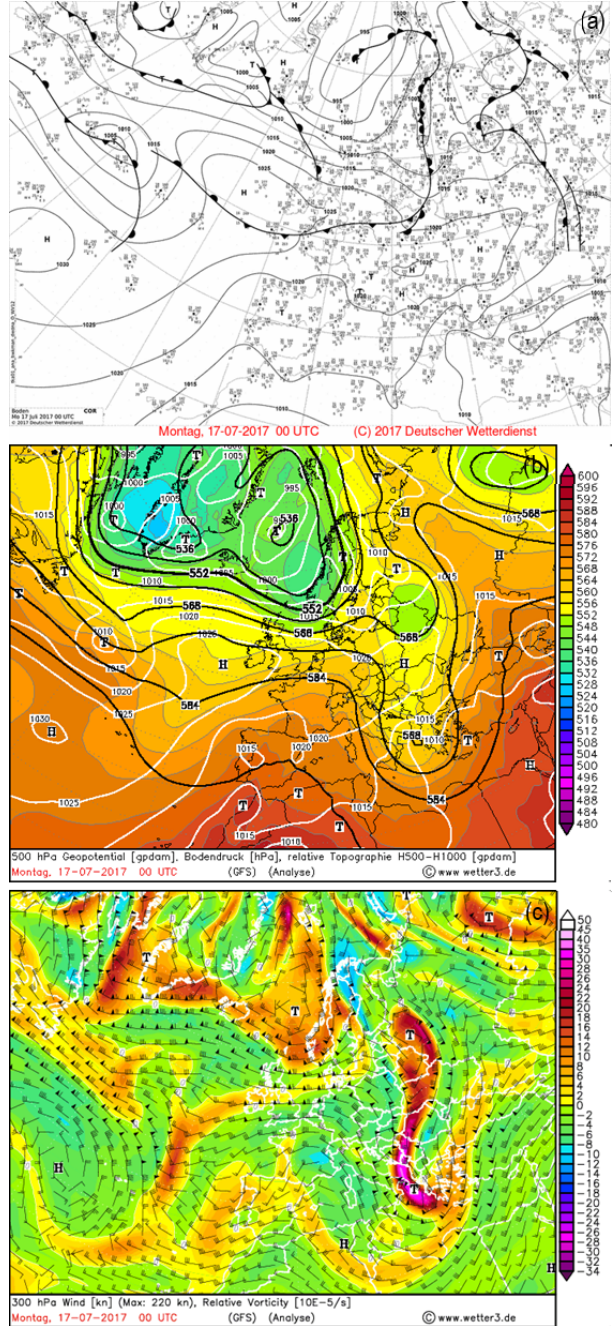
Figure 6. Analysis charts for Europe at 00:00UTC (approximately 2h after the ignition) on 17 July 2017 of (a) mean sea level pressure (hPa; black contours) and fronts; (b) 500hPa geopotential (gpdam; black contours), surface pressure (hPa; white contours), and rela- tive topography RT 500 / 1000 (gpdam; colored); and (c) 300hPa wind (kt, where 1kt = 0.51ms − 1 ; wind barbs) and relative vor- ticity (10 − 5 s − 1 ; colored). The Split wildfire location on charts is indicated as a red dot. (The charts are available from https: //www1.wetter3.de/archiv/, last access: 18 August